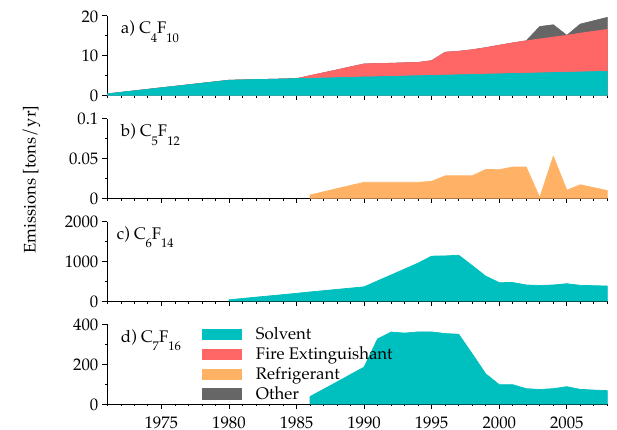
Fig. 2. Global annual bottom-up emission estimates from 1971 to 2008 by source from EDGARv4.2 for (a) C 4 F 10 , (b) C 5 F 12 , (c) C 6 F 14 and (d) C 7 F 16 (ER-JRC/PBL, 2011). (Note: C 8 F 18 is not available from